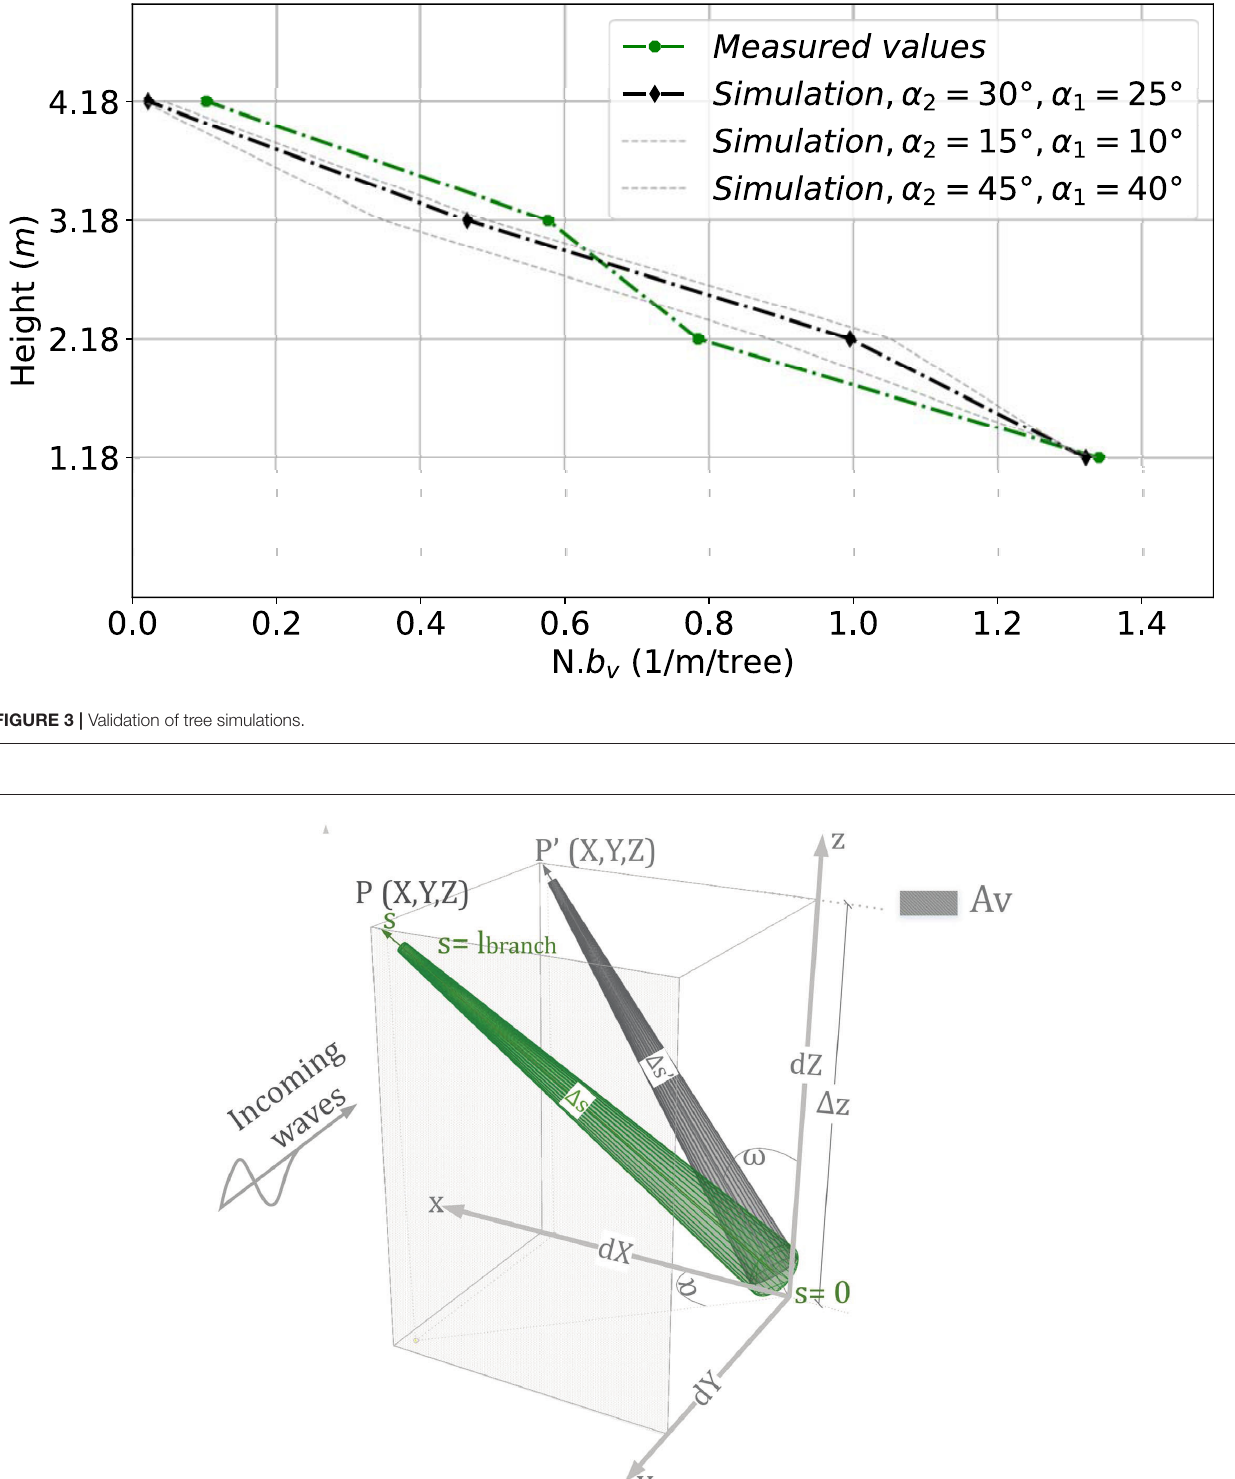
FIGURE 4 | Schematic of the coordinate system used for calculating A v with the incoming waves from the positive y-direction. P is the endpoint of the branch, and P’ is the projected branch perpendicular to the incoming waves.